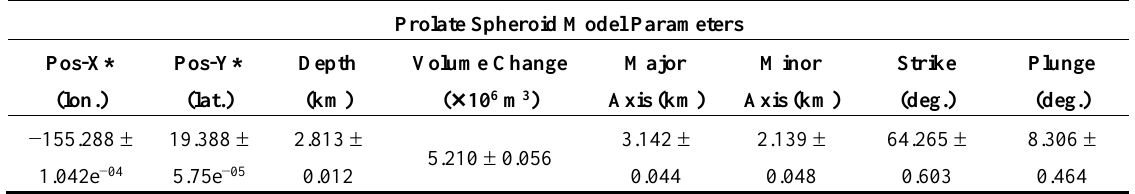
Table 3. The best-fit prolate spheroid model parameters of Kīlauea’s magma source.